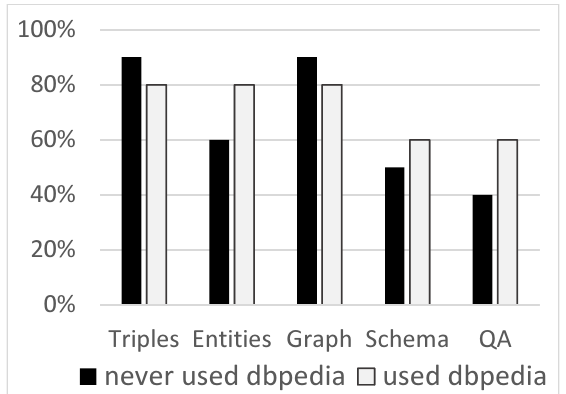
Figure 10. ‘Very Useful’ and ‘Useful’ preference percentages per tab and category of